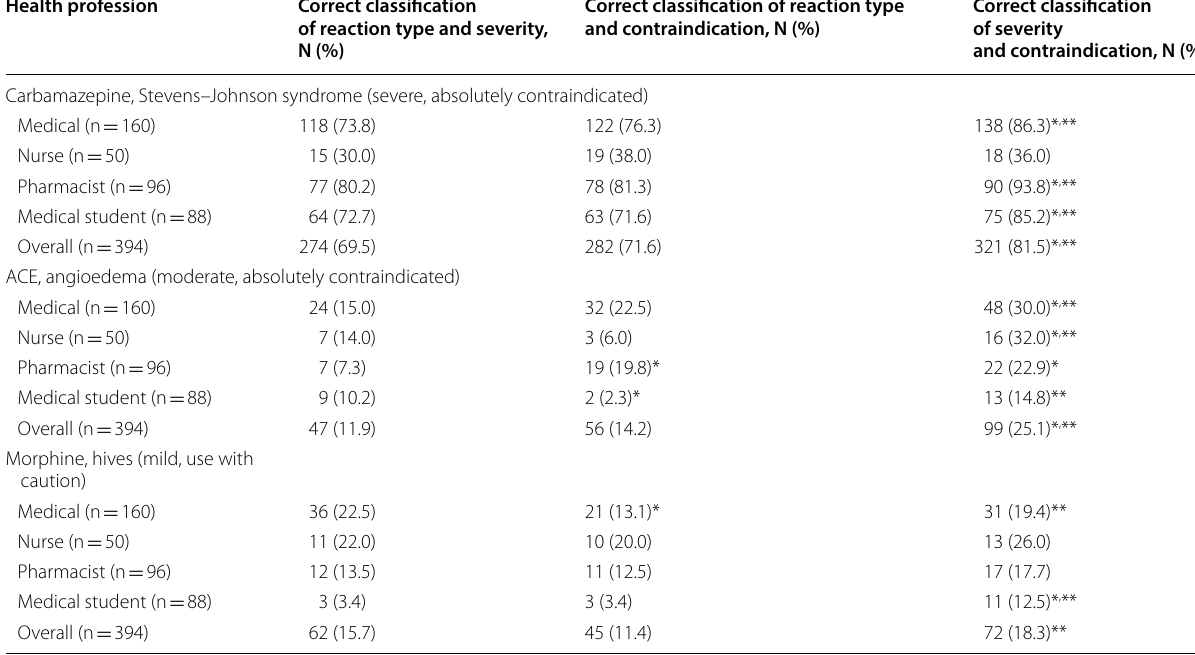
* p < 0.05 by comparison to ‘correct classification of reaction type and severity’ ** p < 0.05 by comparison to ‘correct classification of reaction type and